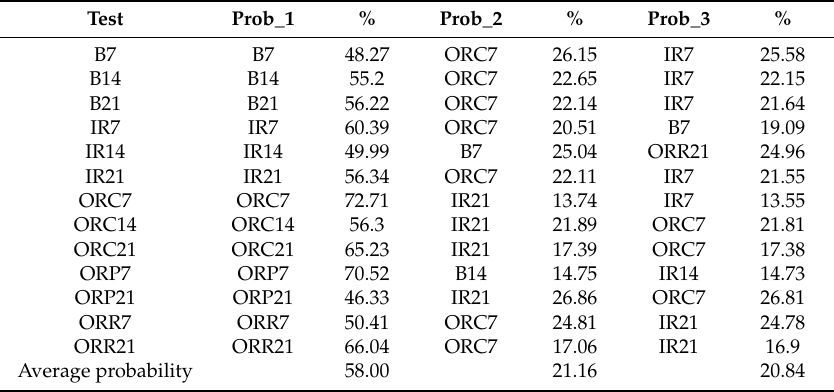
Table 5. CMO-Learning results on CWR Bearing Data